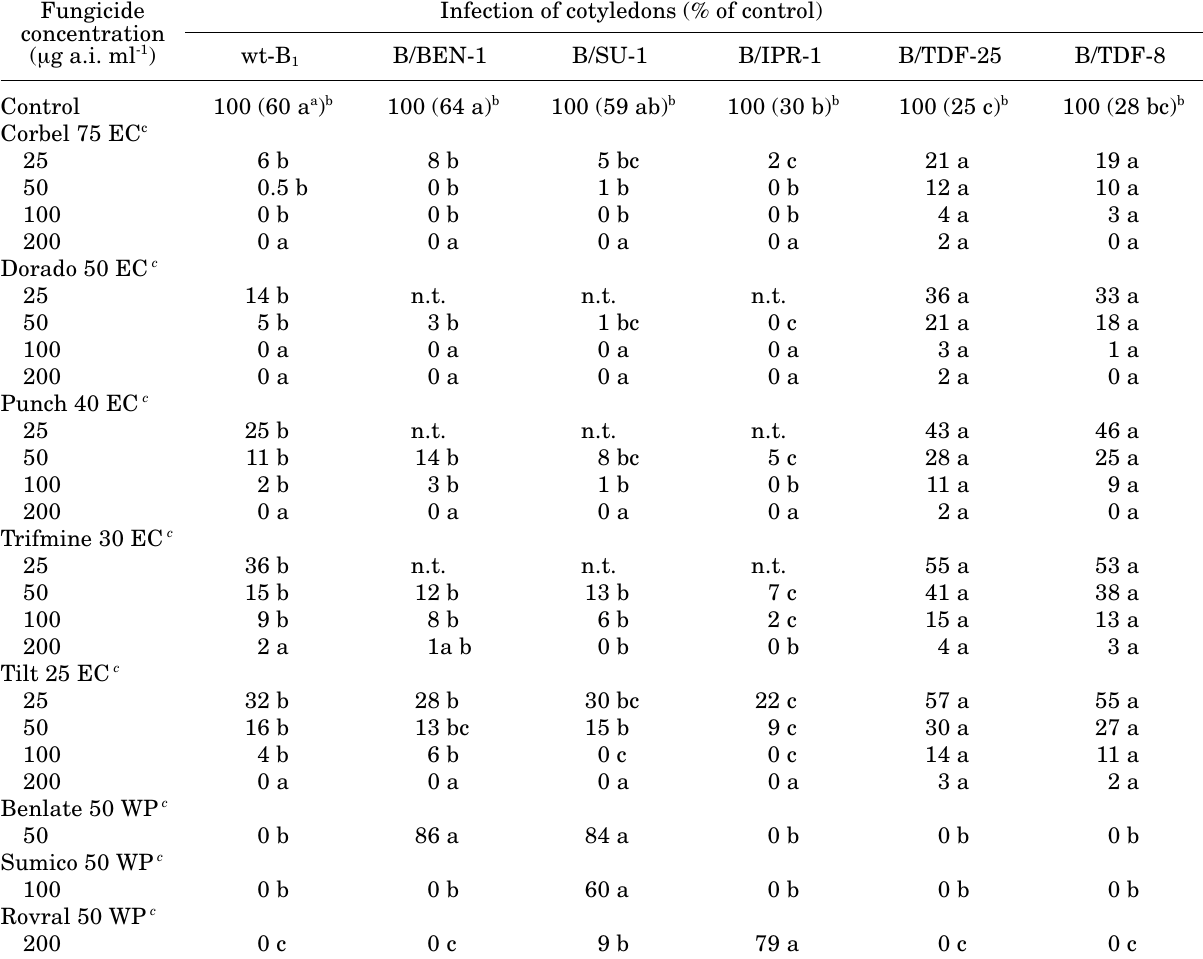
Table 3. Effect of fungicides on lesion development following inoculation of cucumber seedlings with the sensitive, ), and the resistant strains (B/BEN-1, B/SU-1, B/IPR-1, B/TDF-25, B/TDF-8) of Botrytis wild type strain (wt-B 1 cinerea .